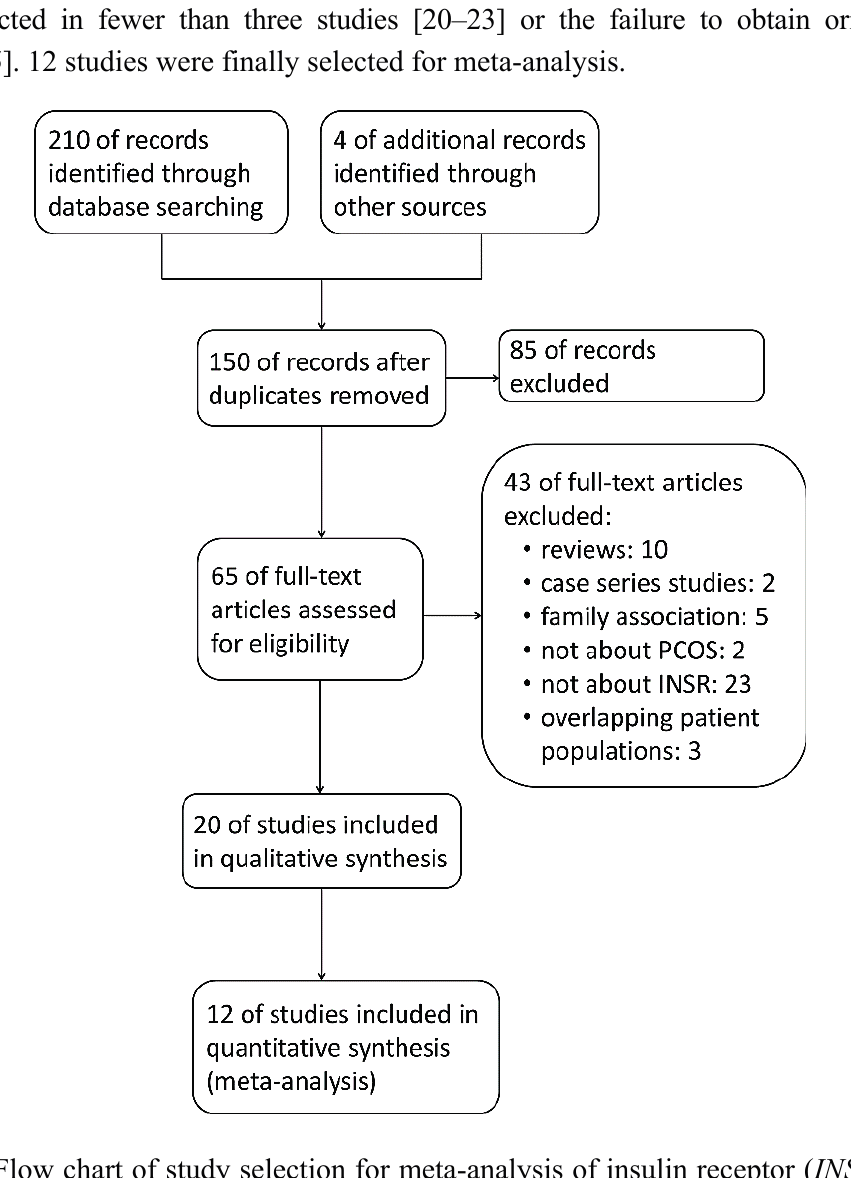
Figure 1. Flow chart of study selection for meta-analysis of insulin receptor ( INSR ) single nucleotide polymorphisms (SNPs) and risk of polycystic ovarian syndrome